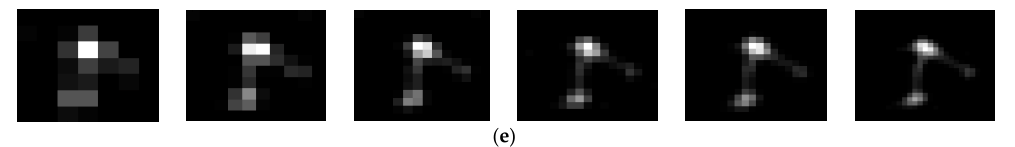
Figure 6. Comparison of results with and without the refinement step using same selected ∇ S maps. ( a ) Blurred image; ( b ) estimated sharp image and blur kernel without the refinement step; ( c ) estimated sharp image and blur kernel with the refinement step; ( d ) show the iterations of the blur kernel estimation without the refinement step; and ( e ) show the iterations of the blur kernel estimation with the refinement step. Without the refinement step, the estimated blur kernel contains some noise which may deteriorate the deblurred image. Restored image in (c) and blur kernel in (e) outperform the results in (b,d).